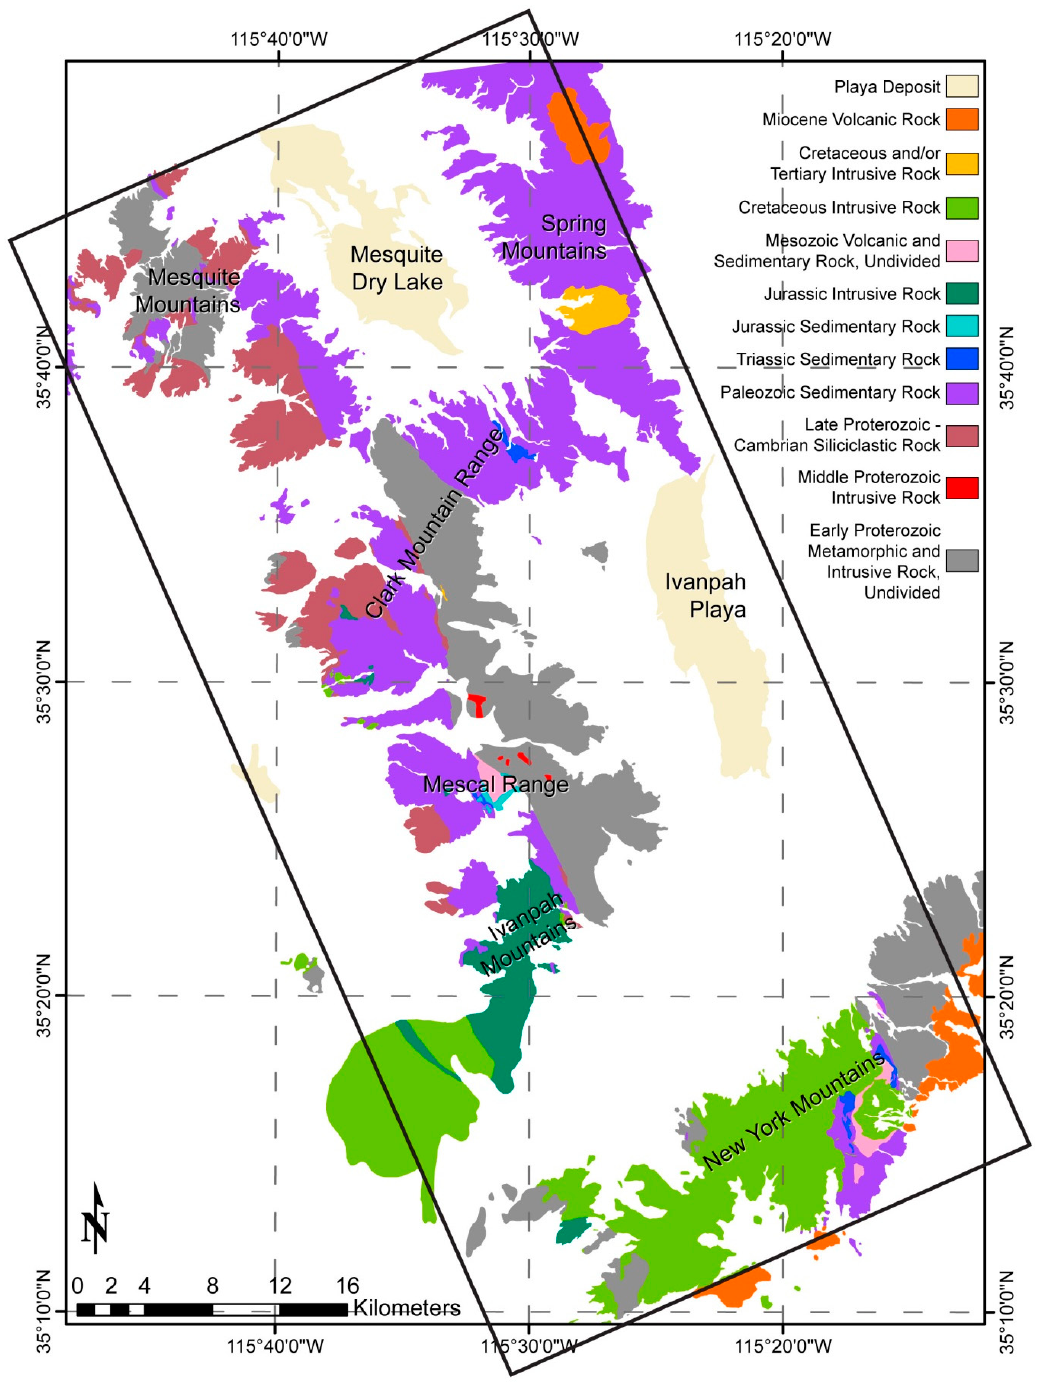
Figure 2. Simplified surface geologic map indicating general lithology and notable features, based on the surficial and geologic maps of Schmidt and McMackin [29], Miller et al. in [31] and Hewett [32]. The solid black outline gives the approximate extent of the study area covered by the spectral imagery.